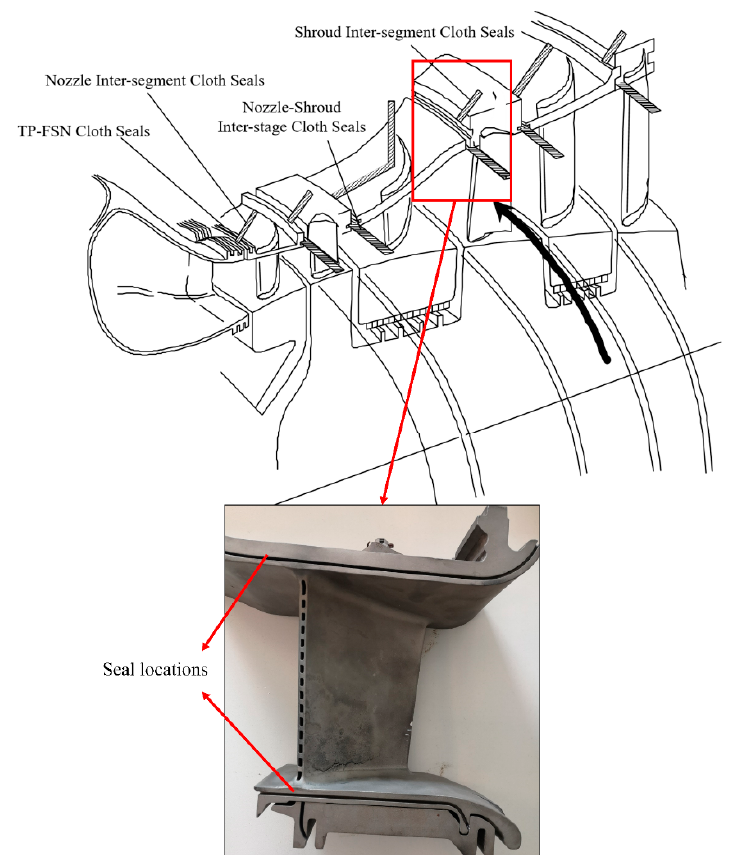
Figure 1. Stationary sealing slot in a gas turbine stator.